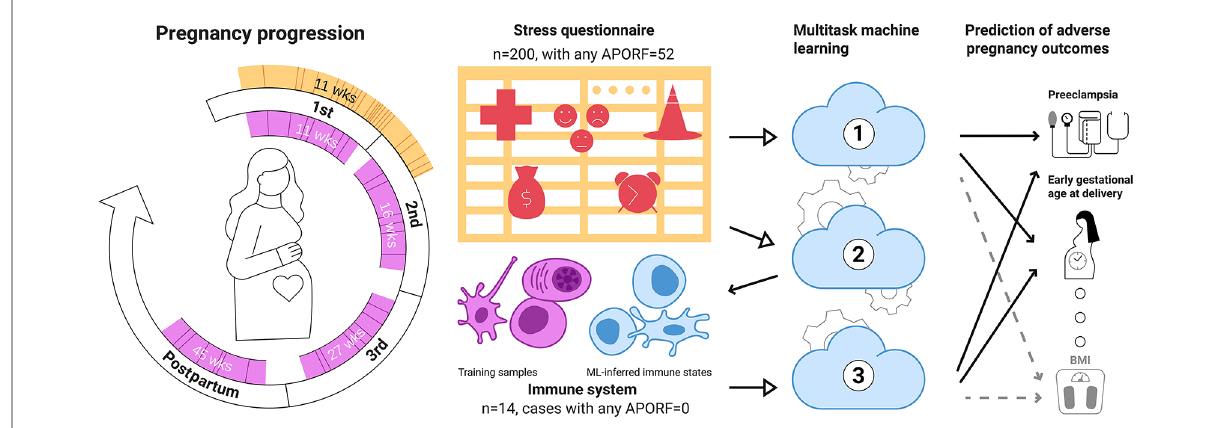
FIGURE 1 Multitask machine learning for the joint modeling of adverse pregnancy outcomes, stress, and biology. A stress questionnaire assessing psychosocial and stress-related factors (PSFs) related to perceived pregnancy risks, emotions and feelings, and life stress was administered during the fi rst trimester (orange) to 200 women. 52 of these women experienced at least one adverse pregnancy outcome (solid lines) or pathophysiological risk factor (dashed lines). Distribution of gestational age at questionnaire completion. In most instances (>95%), the questionnaires were completed before 21 weeks of gestation. The median gestational age when completing the questionnaire was 11 weeks. In addition, patients were followed throughout pregnancy, and immunological data (designated in pink) were obtained during the fi rst (median=11 weeks), second (median=16 weeks), and third trimester (median=27 weeks), as well as at 6 weeks postpartum (median=45 weeks). Model 1: Based on these data, a multitask approach was used to simultaneously model multiple adverse pregnancy outcomes (in bold) as well as risk factors (RFs; Normal font) based on PSFs, building upon their interrelatedness to improve predictions. Model 2: PSFs were used to predict immune system states (pink cells) illustrating a link between stress factors and biological functions. Finally (Model 3), connections among APOs, PSFs and the immune system were investigated by deriving immune states for our wider dataset from PSFs (blue cells) for predicting APOs. Overall, our results point towards a tight relationship between adverse pregnancy outcomes, stress and immune biology. Importantly, they suggest that several PSF categories can be jointly informative in modeling APOs pointing towards potential easily accessible stress-based interventions for